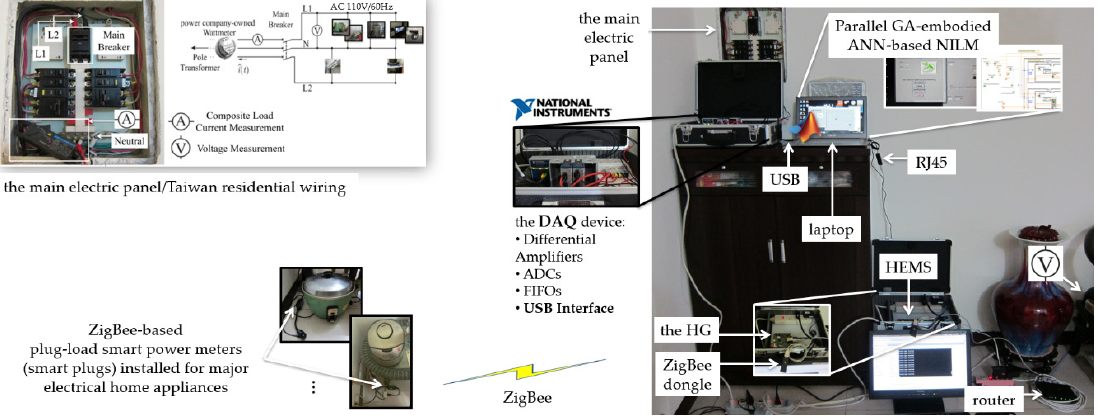
Figure 9. Experimental set-up of the home energy management systems (HEMS) [24] with the NILM in this work.